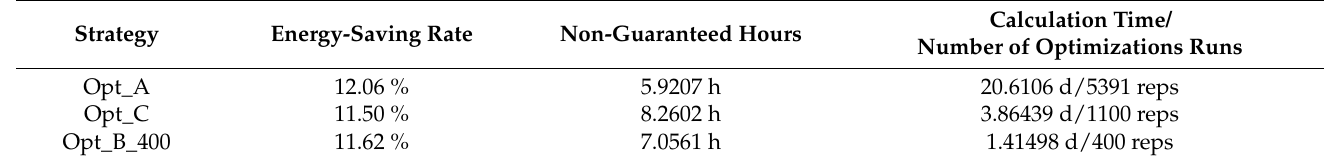
Table 4. Summary of simulated optimization